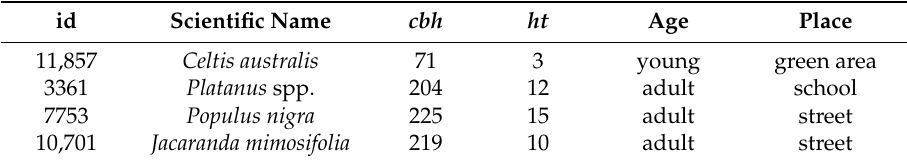
Table 1. Example of the information collected for four individual trees, where cbh stands for circumference at breast height (cm) and ht for height (m).